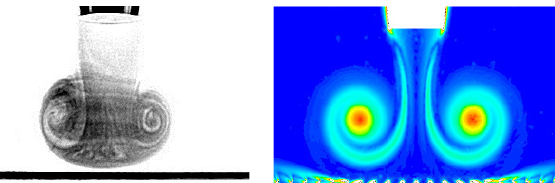
Figure 8. Comparison of air vortex flow structure before hitting the screen, current simulation vs. experimental results from An et al. [14]: φ = 0.8, Re = 1800, t = 0.46 s. The formation, structure, and position of the vortex ring after hitting the screen and while propagating through the screen were also cross-validated with experimental